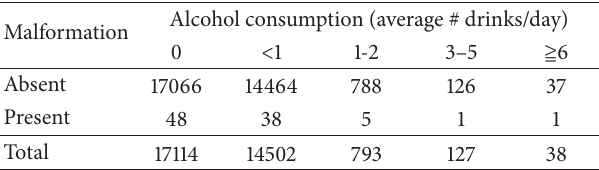
Table 1: Presence or absence of congenital sex organ malformation categorized by alcohol consumption of the mother